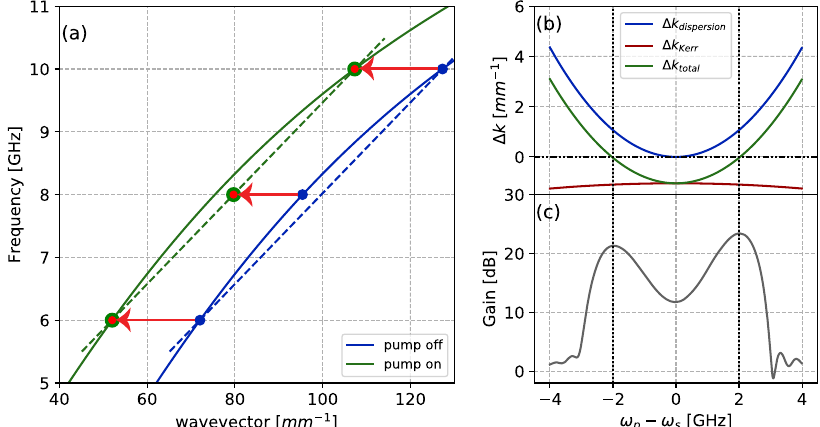
Fig. 1 Reversed Kerr phase matching. a Exaggerated dispersion relations of a weak probe tone in presence of pump at 8 GHz (green) and absence of pump (blue) in reversed Kerr TWPA at negative Kerr fl ux bias. The red arrows indicate the contribution of self phase modulation (SPM, at 8 GHz) and cross- phase modulation (XPM, at 6 and 10 GHz). The XPM experienced by the signal and idler waves is stronger than the SPM experienced by the pump wave, this allows signal, idler and pump to be colinear, i.e., satisfy the phase matching condition. Due to sign reversal of Kerr, self, and cross phase modulation processes cancel phase mismatch arising from curvature in dispersion (blue); which leads to perfect phase matching at 6 and 10 GHz (indicated with red- green points). Simulations of reversed Kerr phase matching and gain ( b , c ) using device parameters. The represented Δ k values are phase mismatches at the output of the